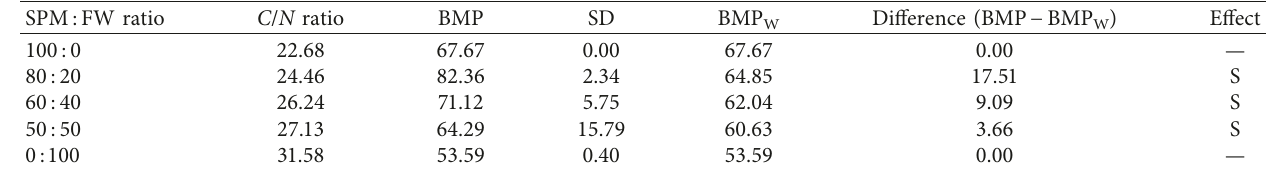
Table 5: Synergistic effects of